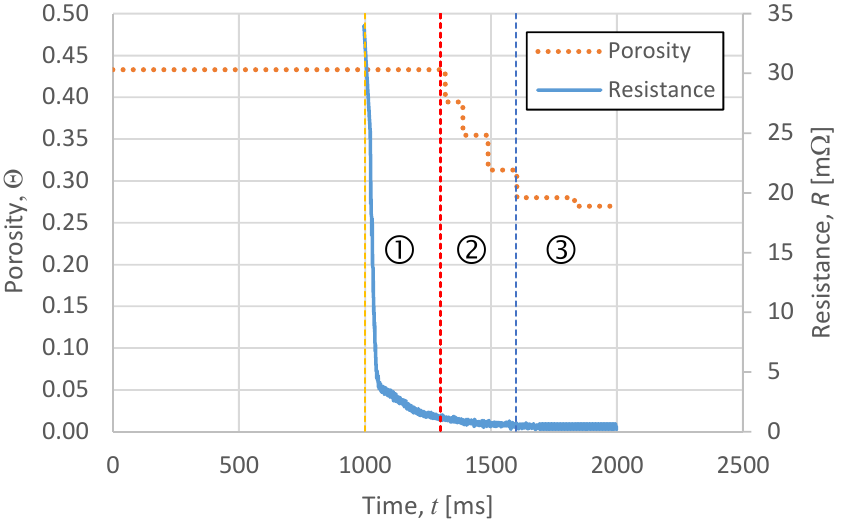
Figure 4. Porosity and electrical resistance evolution in an arbitrarily selected MF-ERS experiment. The vertical line at 1000 ms marks the beginning of the current passing. The other vertical lines separate the process stages discussed in the text. The serrated shape of the porosity curve is a consequence of the noise reduction function of the displacement sensor.